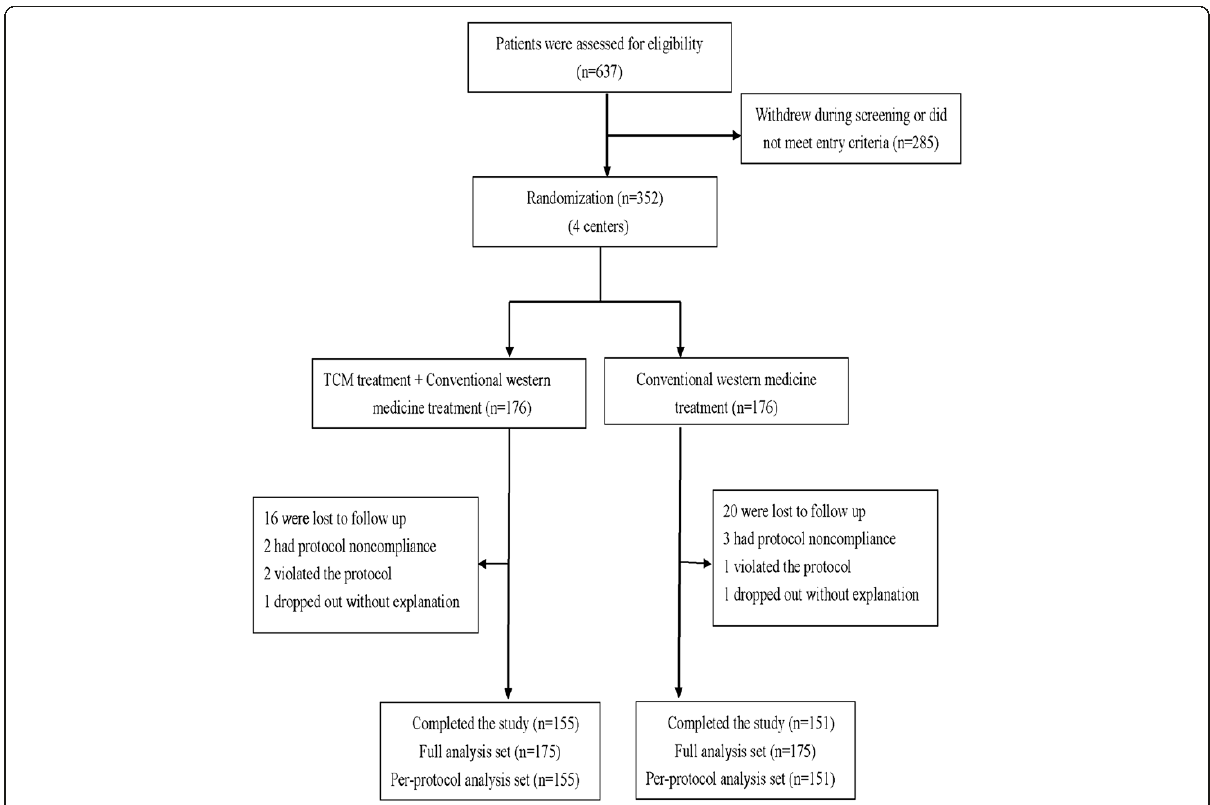
Figure 1 Enrollment of the patients and completion of the